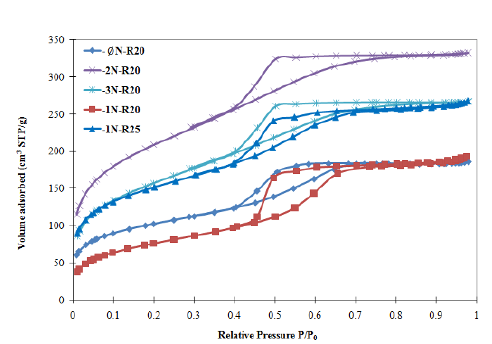
Figure 3. Nitrogen adsorption-desorption isotherms plots at 77 K for materials prepared by in-situ functionalization with amine groups.